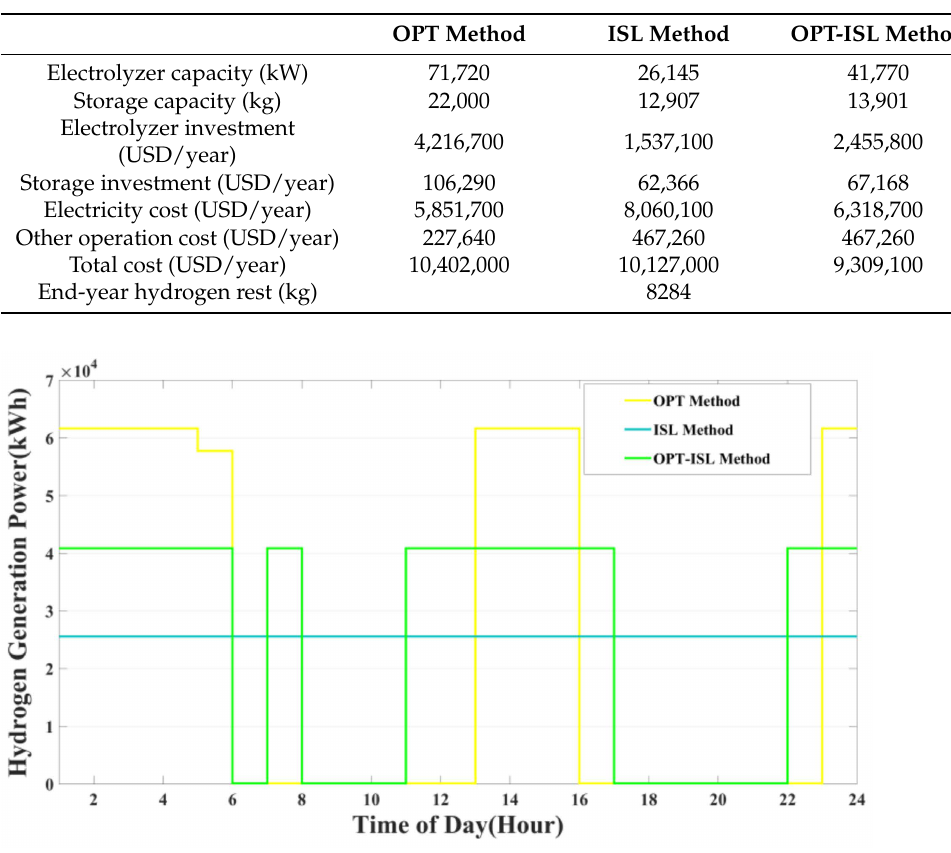
Figure 8. Daily hydrogen generation plan for three